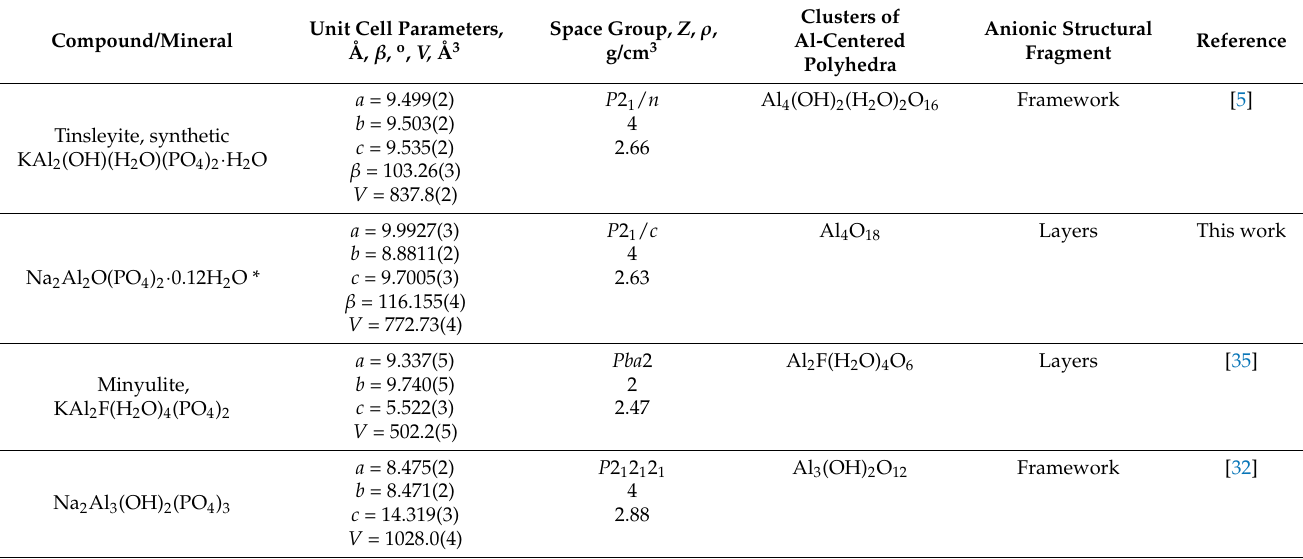
Table 4. Structurally related sodium and potassium microporous aluminophosphates .